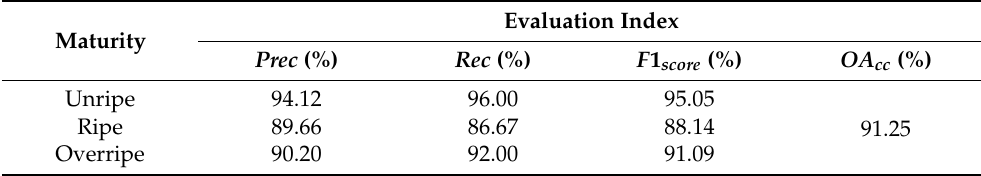
Table 4. Quantitative evaluation results of the identification of Camellia oleifera fruit